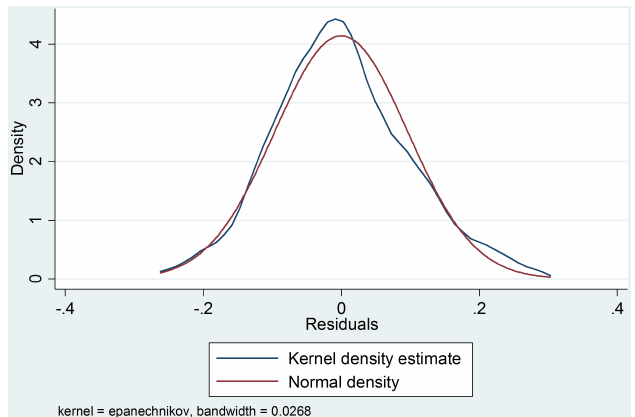
Figure 2: Kernel density